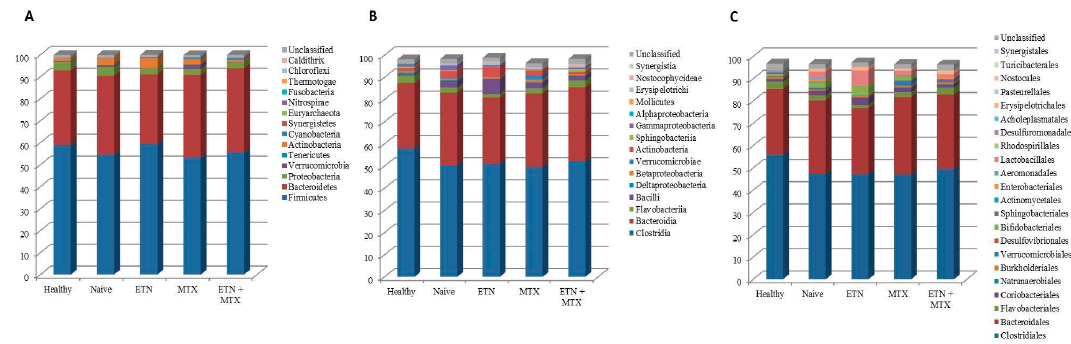
Figure 2. Microbiota composition of healthy controls and different treatment groups of RA patients at the phylum ( A ), class ( B ), and order ( C ) levels. The mean value of the eight top taxonomic classifications at each level is represented.